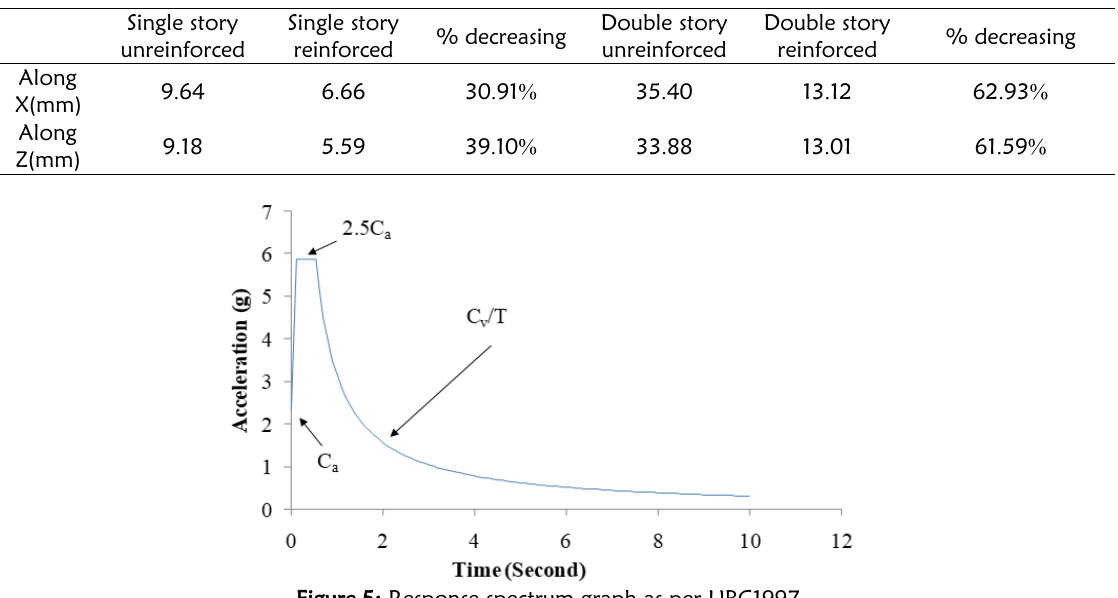
Table 3 : Displacements from response spectrum analysis